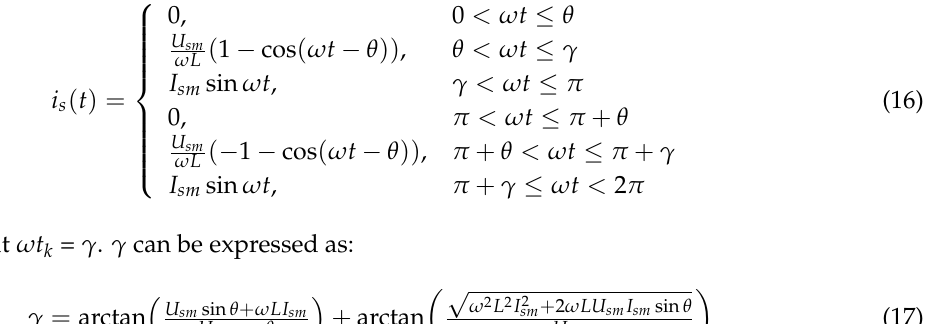
Figure 8. Expected waveforms and actual waveforms of AC side fundamental voltage and current with complementary drive under leading power factor.